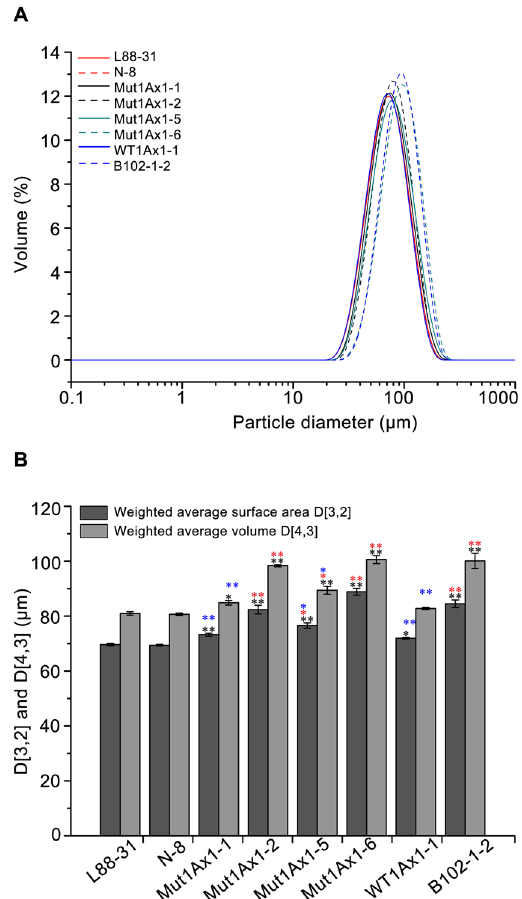
Figure 5. Effects of Mut1Ax1 on GMP particles size distribution. ( A ) The size distribution patterns of GMP particles extracted from defatted flour samples. ( B ) Weighted average diameters D[3,2] and D[4,3] of GMP particles. Bars represent the mean ± SEM (n = 4). * / ** Show the comparisons between all transgenic lines and negative controls (L88-31 and N-8) on the two parameters above, while and represent comparisons between transgenic lines expressing mut1Ax1 and line WT1Ax1-1 and comparisons between those lines and line B102-1-2, respectively ( * P < 0.05, ** P < 0.01 by Student’s